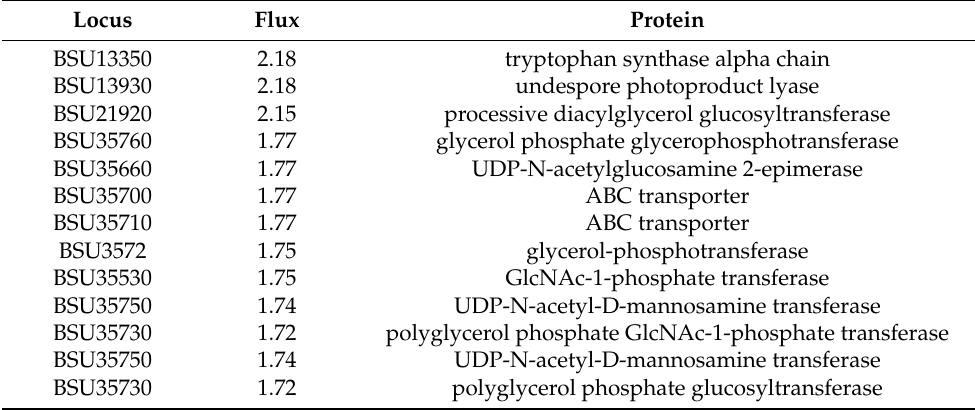
Table A2. List of genes from the Single Gene Deletion